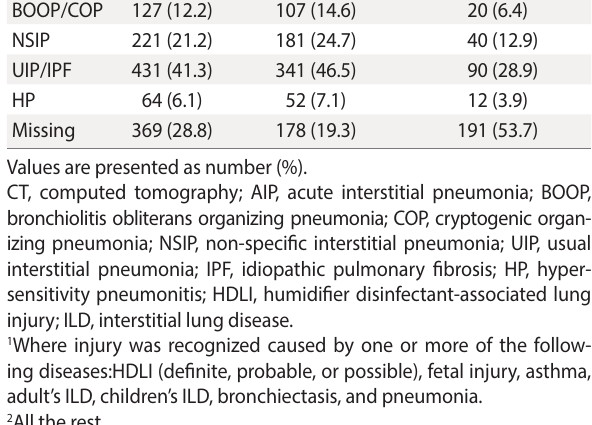
Characteristics